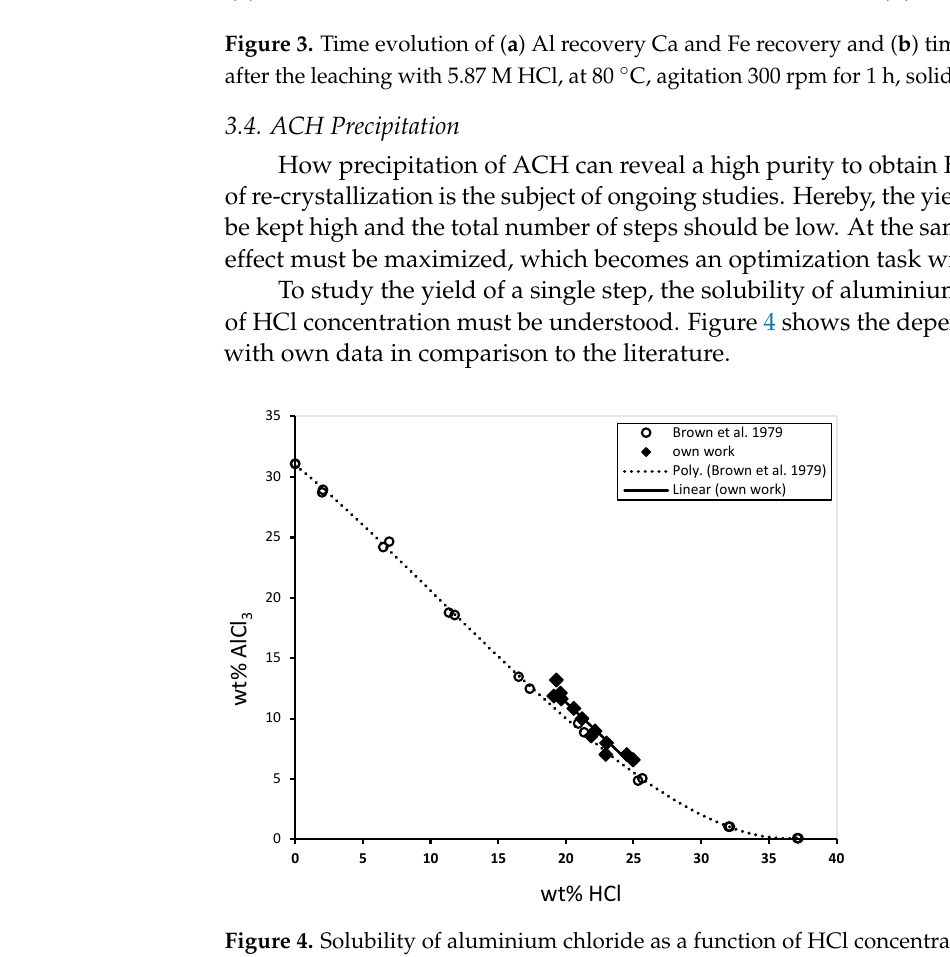
Figure 4. Solubility of aluminium chloride as a function of HCl concentration.